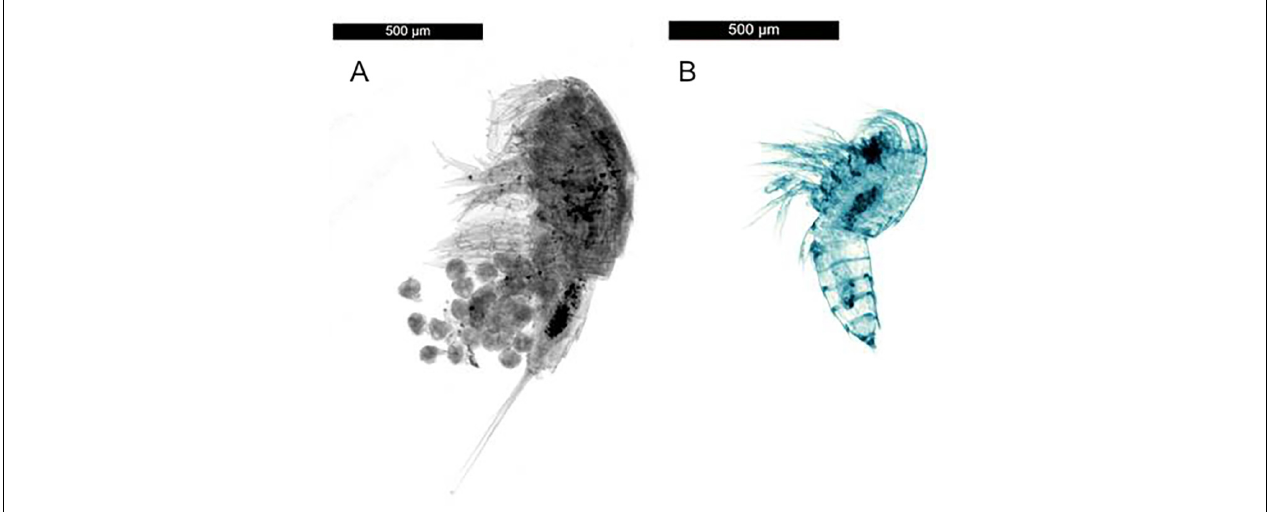
FIGURE 6 | Microscope images of (A) Tisbe sp. nov. (with nauplii), and (B) Amphiascus sp. nov.